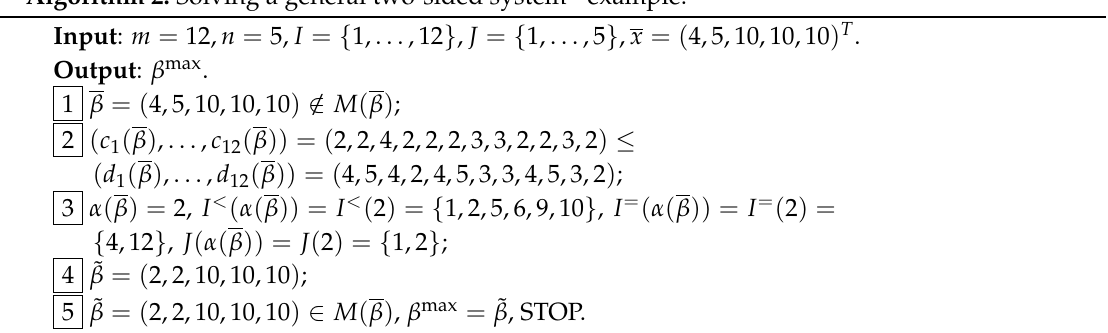
Algorithm 2: Solving a general two-sided system -